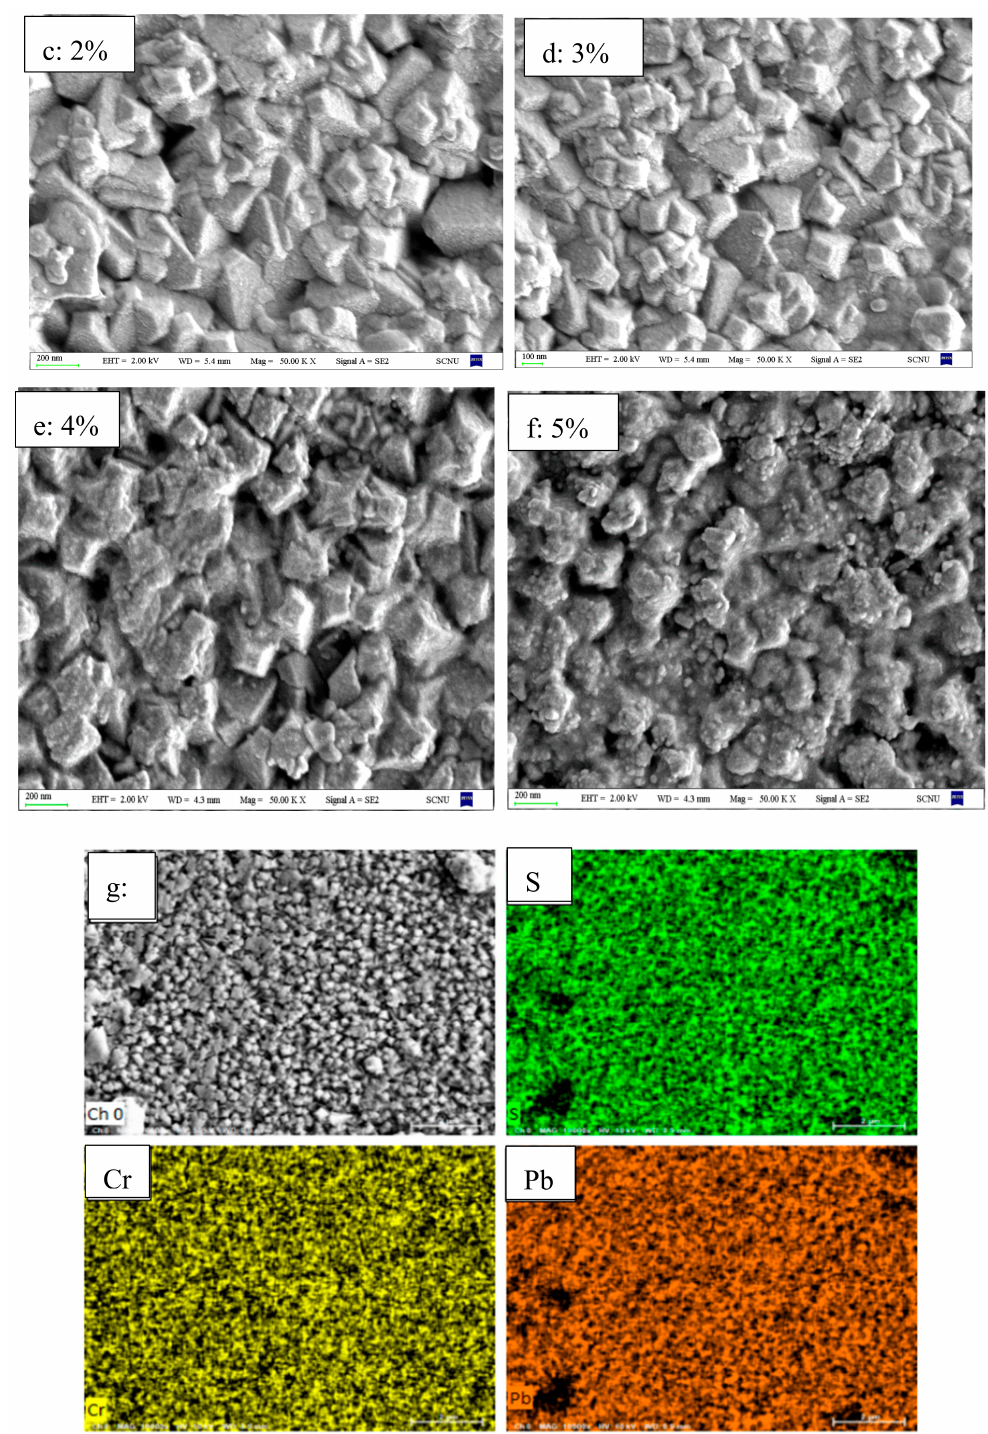
Figure 2. SEM micrographs for ( a ) undoped and Cr-doped (( b ) 1%, ( c ) 2%, ( d ) 3%, ( e ) 4%, and ( f ) 5%) PbS films. ( g ) Energy-dispersive X-ray spectroscopy (EDS) elemental mapping of Pb, Cr, and S for the 5% Cr-doped film, scale bar: 2 µ